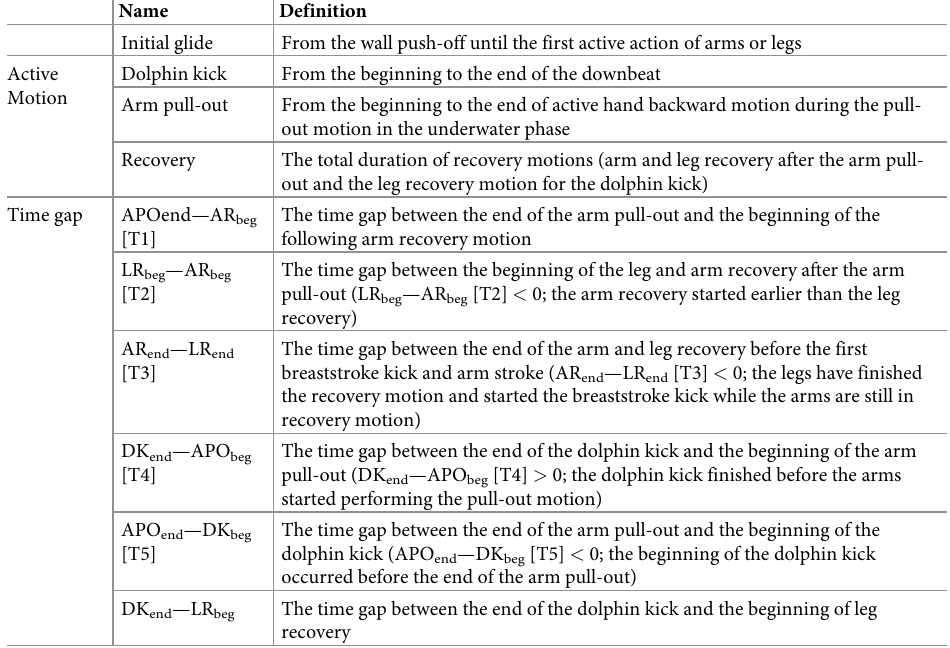
Table 1. Definition of analysed active motions and time gaps in the present